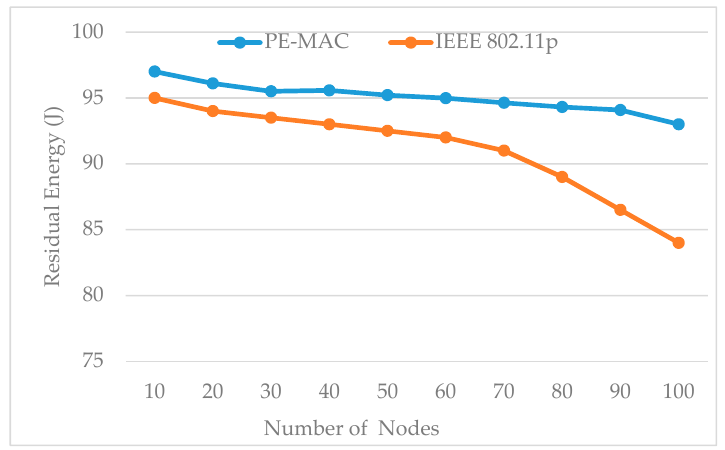
Figure 10. Impact of number of nodes on residual energy: proposed PE-MAC vs IEEE 802.11p.